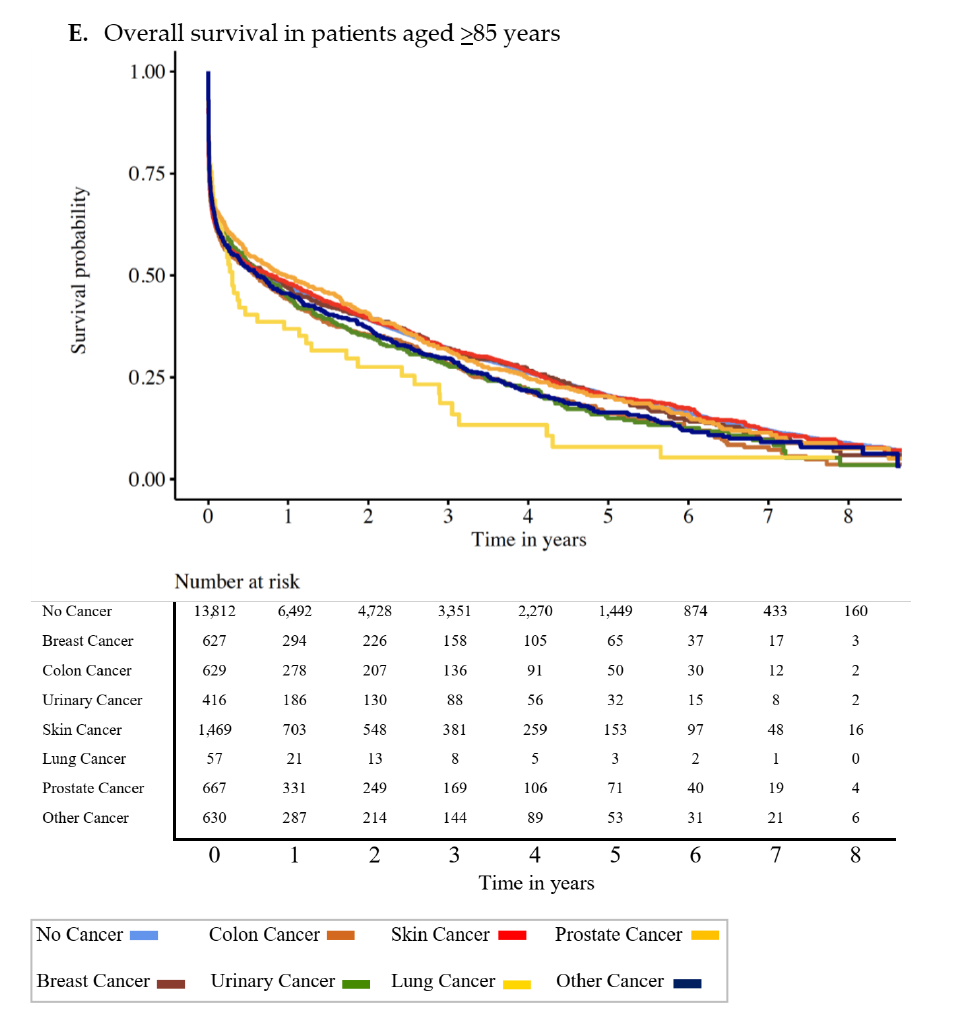
Figure 1. ( A – E ). Kaplan – Meier survival curves in STEMI patients with or without cancers and different age groups. Survival in all age groups ( A ): here the worst survival rates for patients with STEMI and lung cancer were documented, followed by colon, urinary, prostate, breast, other, and skin cancer. ( B ) Probability of survival in patients under 65 years of age, ( C ) 65 – 74 years of age, ( D ) 75 – 84 years of age, and ( E ) patients > 85 years of age. The cancer related differences in survival disappeared with age. After adjustment for patients ’ risk profile, the most serious comorbidities with a statistically significant increased risk of death were lung cancer (HR 2.04; 95CI 1.92 – 2.17),